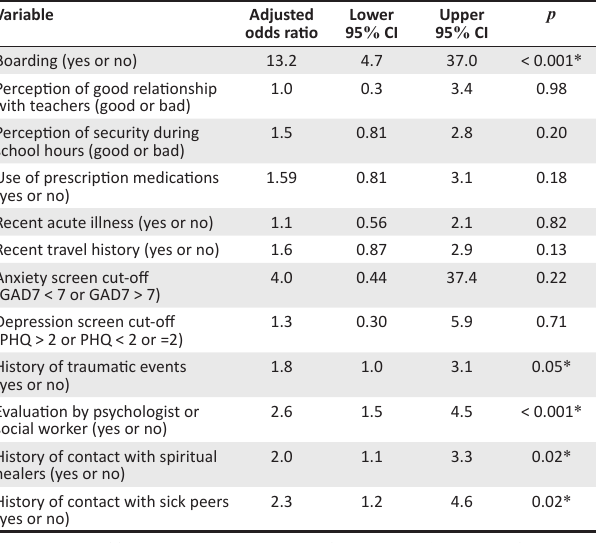
TABLE 4: Association between mass psychogenic illness and independent variables (multivariate model). Variable